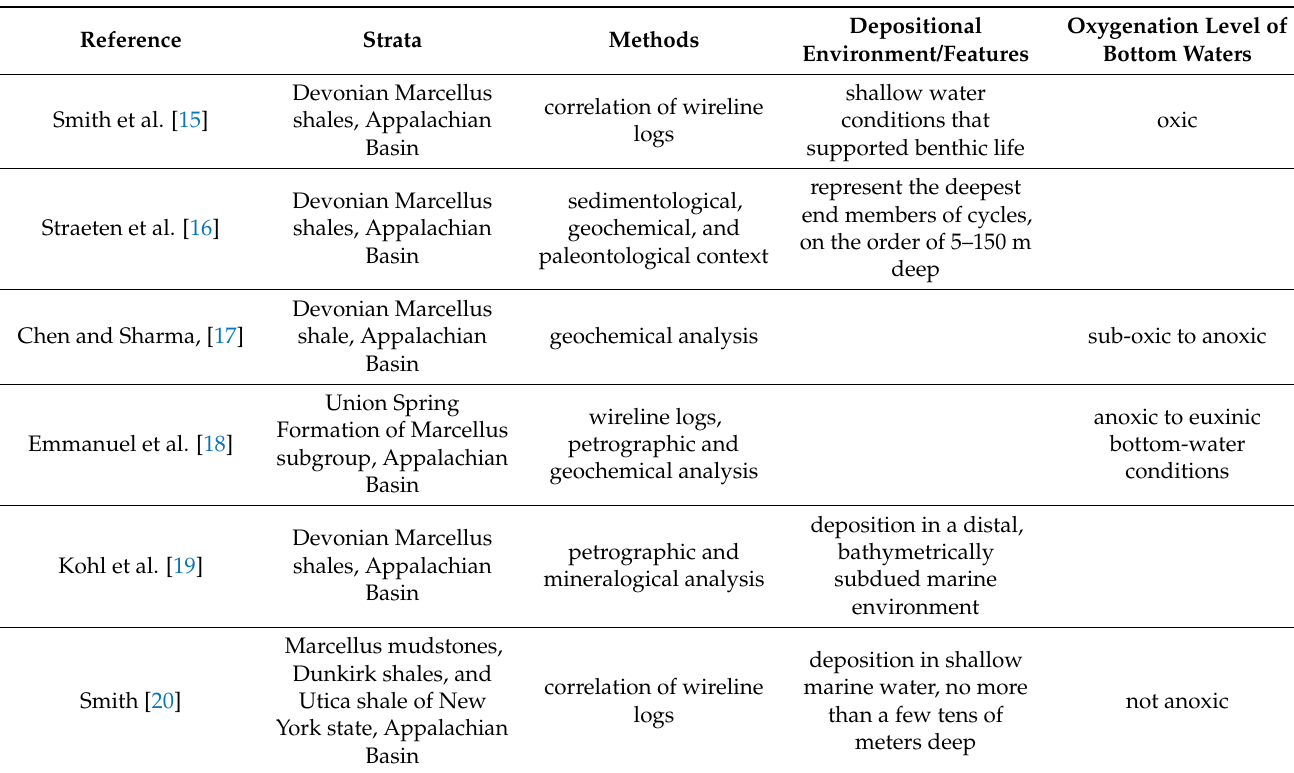
Table 1. Depositional environment and physiochemical conditions during the deposition of Marcellus black shales, Appalachian Basin, reported in